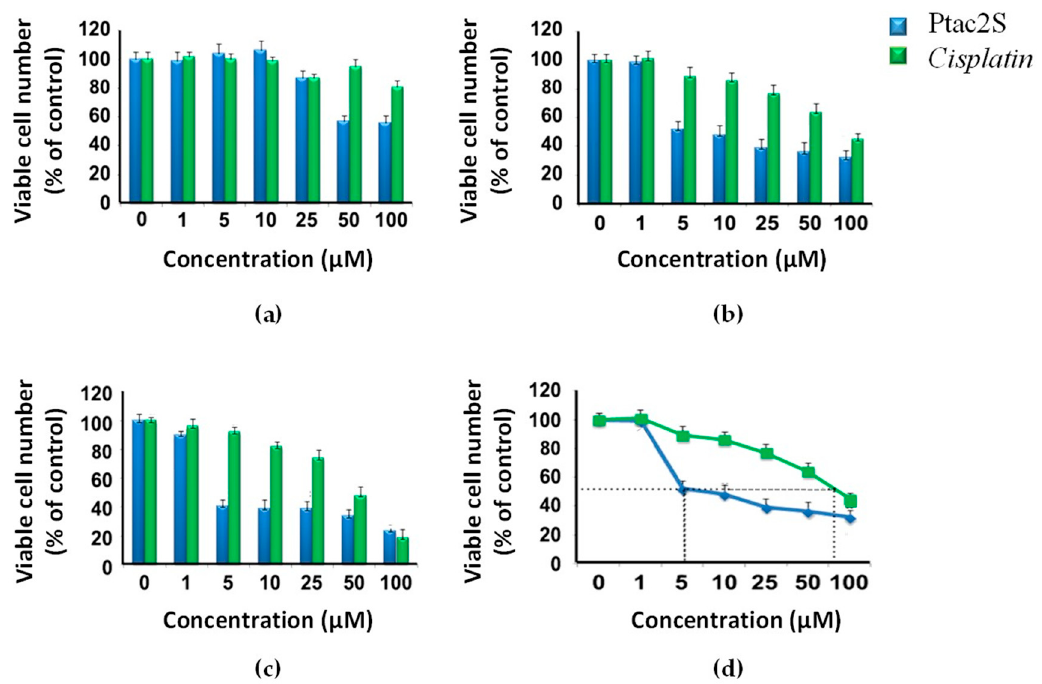
Figure 2. Evaluation of the cytotoxicity of Ptac2S on SKOV-3 cells in comparison with cisplatin . The SKOV-3 cells were treated with increasing concentrations of Ptac2S or cisplatin by determining the viable cell number after 12 h ( a ), 24 h ( b ), 48 h ( c ). Panel ( d ) shows the IC 50 of Ptac2S and cisplatin after 24 h.